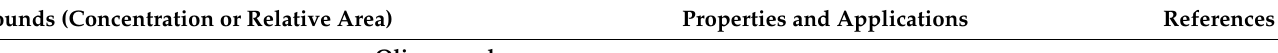
Table 1. Main bioactive compounds from olive tree wood and their applications. * n.d.: not detected. ** ↑ : Increase. Chemical structures by families are shown in Figure